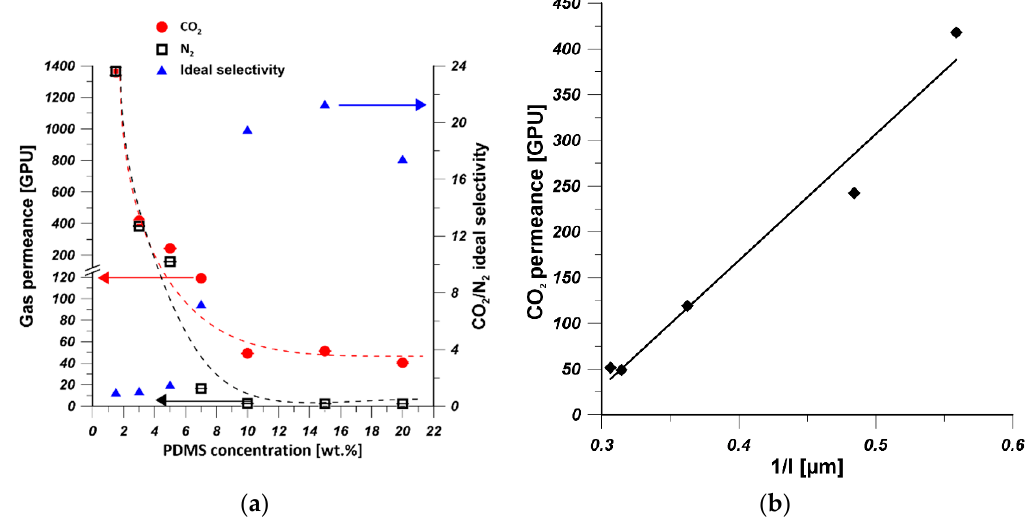
Figure 6. ( a ) The effect of PDMS concentration on gas permeance and ideal selectivity of PDMS/PEI membranes prepared at coating time of 10 min (the dashed line only indicates the trend of gas permeance change). ( b ) The influence of PDMS layer thickness on CO 2 permeance of PDMS/PEI membranes prepared from various PDMS concentrations, at a coating time of 10 min (the average thickness of PDMS layer was calculated based on the thickness of PDMS layer at the top and bottom parts).